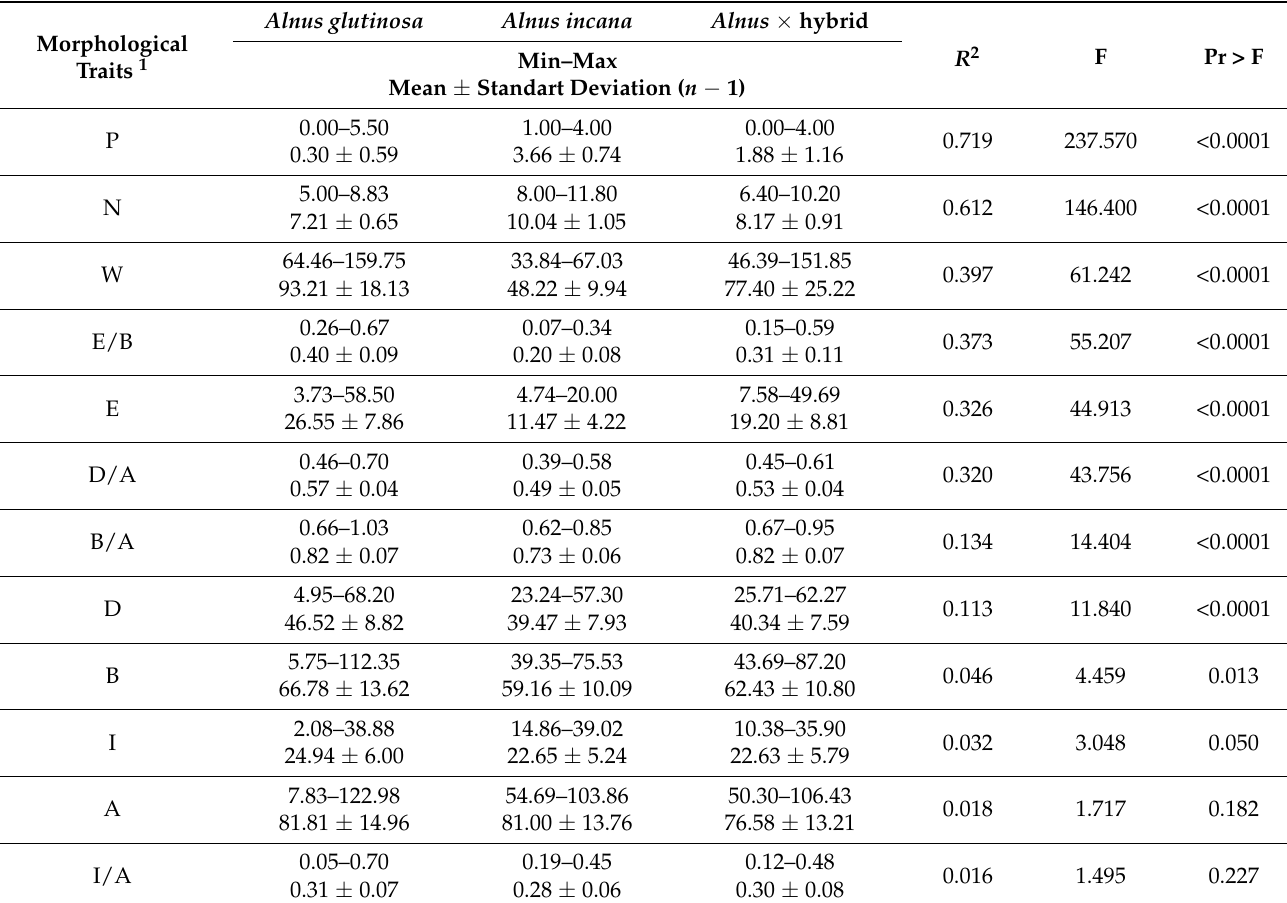
Table 2. Description statistics and results of ANOVA on the effect of species on the leaf morphology traits of alders and their hybrids. The model R 2 , F value, and Pr > F from ANOVA are given for n = 189 individuals.